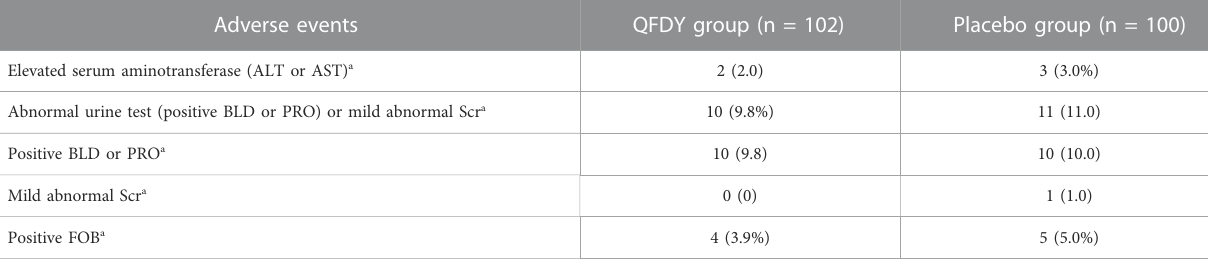
TABLE 5 Analysis of safety